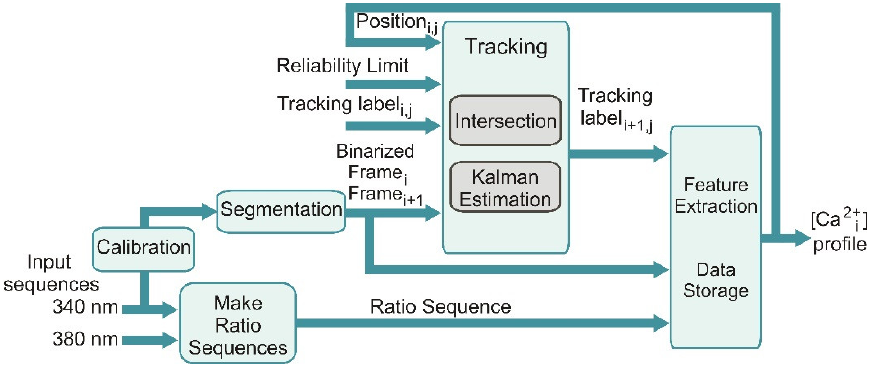
Figure 5. Block diagram of the proposed solution.